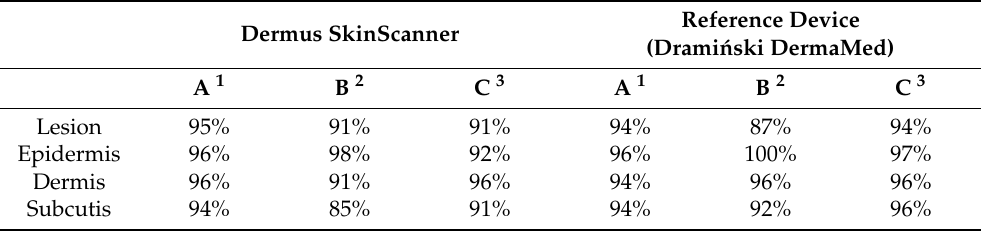
Table 1. Detectability of the lesion and primary layers associated with the skin for the investigated and reference devices. (N = 53). Dermus SkinScanner